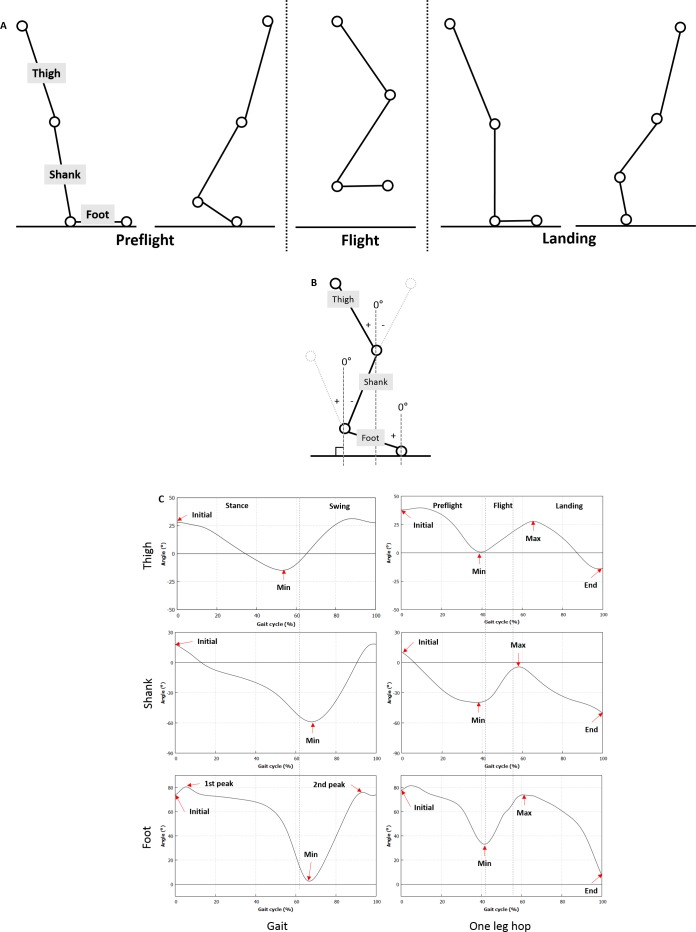
Definition of the segment angle and the phase and specific values of the segment angle.(A) The one-leg hop activity is divided into the preflight, flight, and landing phases. (B) The sagittal angles of the thigh, shank, and foot with the vertical axis to the ground are calculated by using the marker data obtained from the motion analysis system. (C) Specific sections of the segment angle curves are defined.